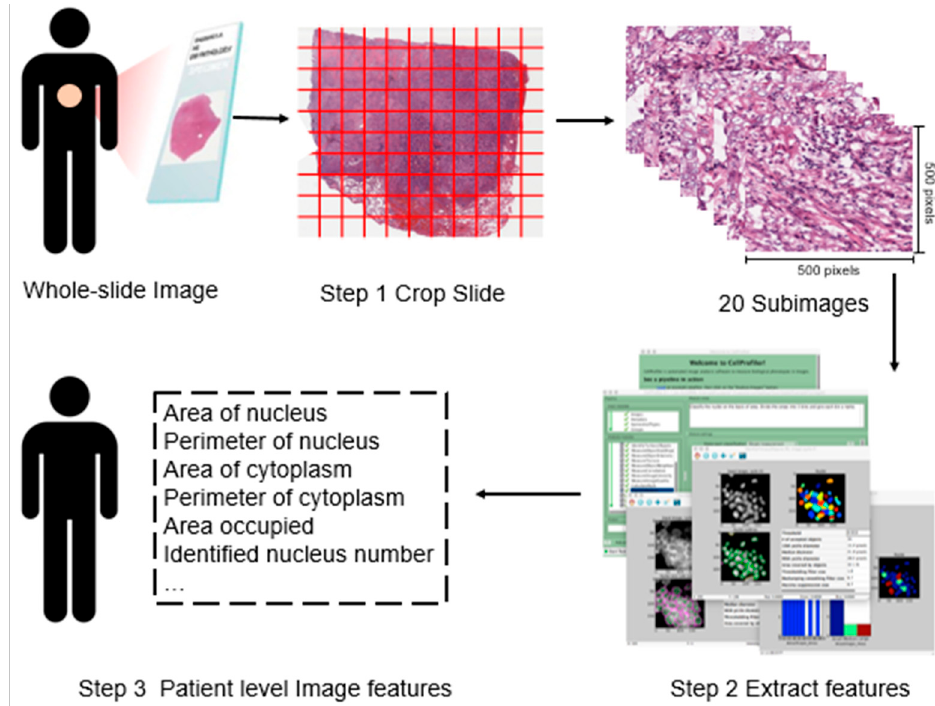
Figure 1. Flowchart of extracting imaging features. Step 1: whole-slide histopathology images are cropped into small subimages of 500 × 500 pixels, and 20 subimages are then randomly selected. Step 2: Imaging features are extracted using CellProfiler [19] for each subimage. Step 3: For each patient, features are averaged.